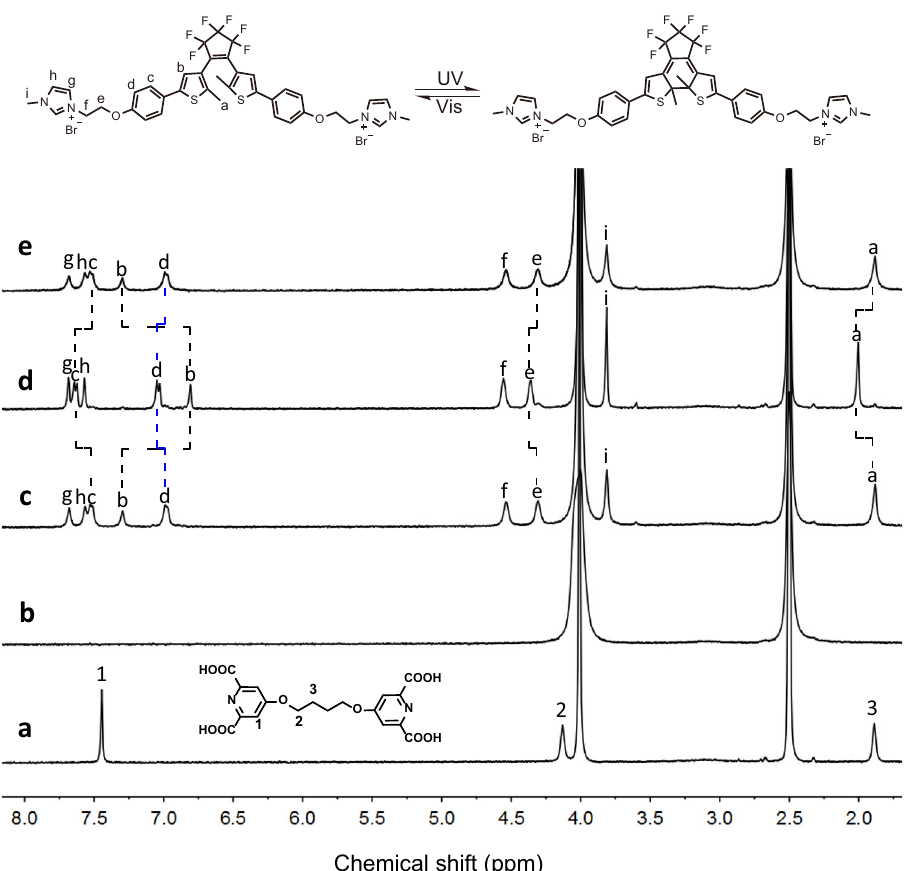
Fig. 2 1 H NMR spectral studies. Partial 1 H NMR spectra (DMSO:D 2 O = 4:1, 400 MHz, 25 °C) of a compound L , b Eu 3 + - L , c-e Eu 3 + - L -OF- 1: c before and d after the irradiation by UV light (300 nm, 60 min), and e subsequent irradiation with visible light (> 450 nm, 60 min). [Eu 3 + ] = 1.4 × 10 -4 M, [ L ] = [OF- 1 ] = 2.1 × 10 − 4